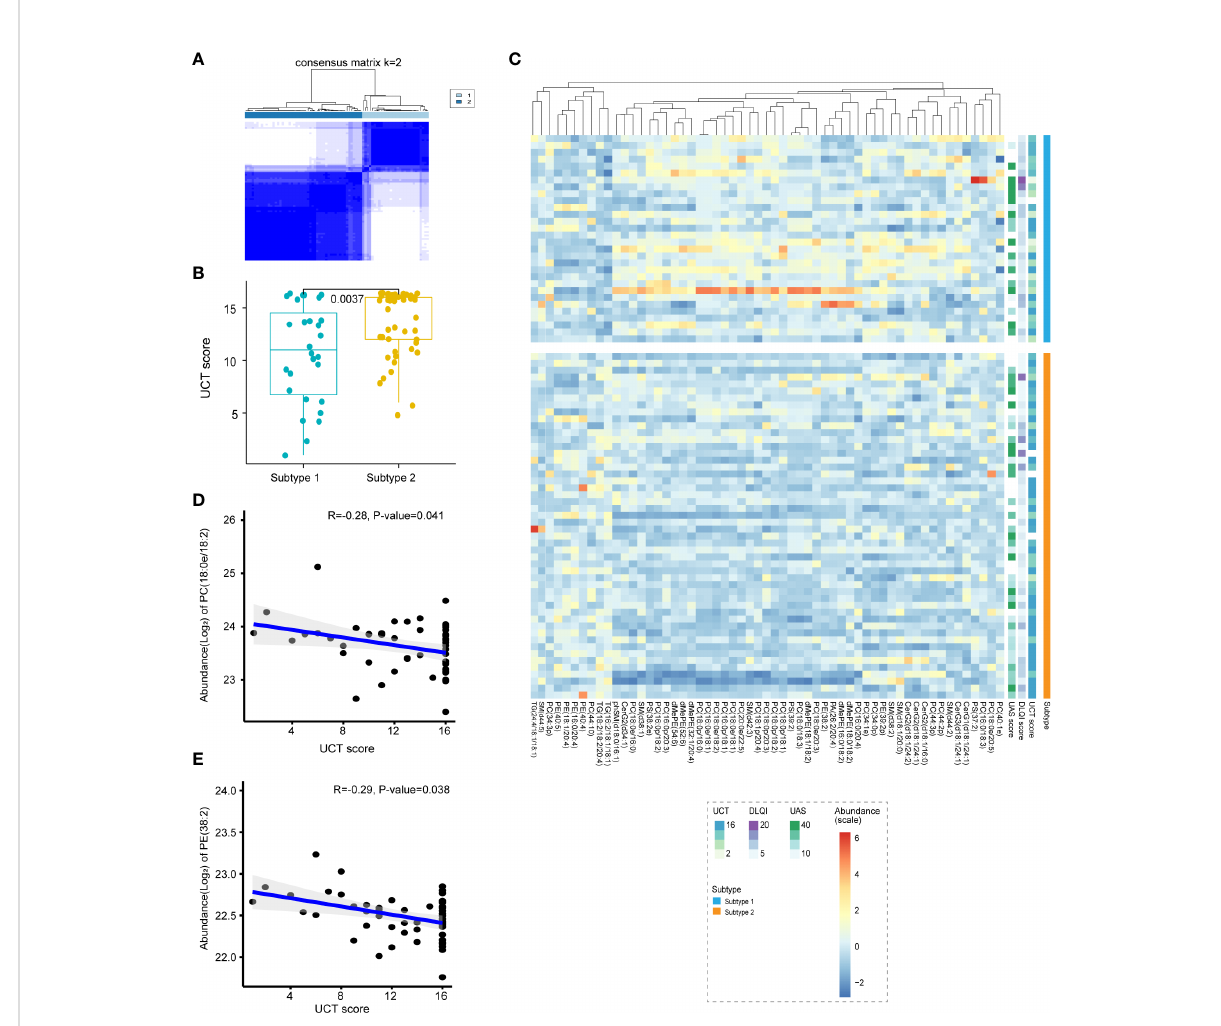
FIGURE 4 Classi fi cation of CU lipid subtypes based on pro fi ling. (A) The heat map corresponding to the consensus matrix for 2 metabolite subtypes was obtained by applying consensus clustering. (B) CU was classi fi ed into two subtypes based on lipid pro fi ling, subtype 2 shared higher UCT scores compared with subtype 1. (C) The heatmap of all differential lipids related with subtype 1 (blue) and subtype 2 (orange), which was generated using the heatmap function in R with subtypes, UAS7 (green), DLQI (purple) score and UCT (blue) score as the annotations. The colors range from blue to red, indicating strength from low to high. (D, E) Plasma PC (18:0e/18:2) (R=-0.28, P-value=0.041) and PE (38:2) (R=-0.29, P-value=0.038) levels were negatively correlated with UCT